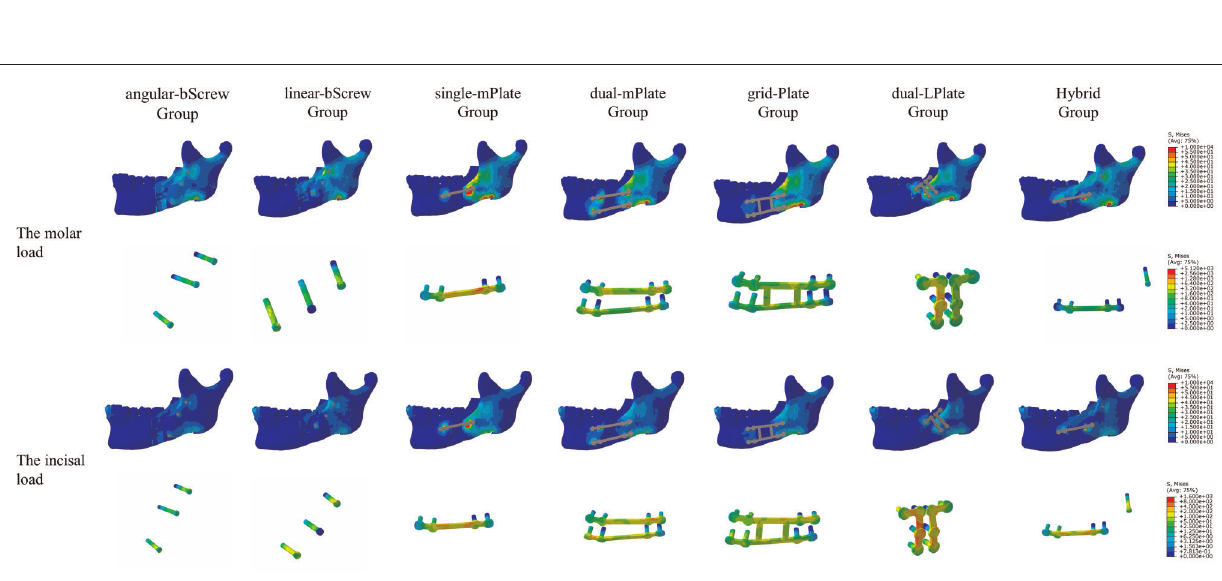
FIGURE 4 | Distribution of von Mises stress on mandibles and the von Mises stresses results for seven fi xation methods with a 5 mm advancement.